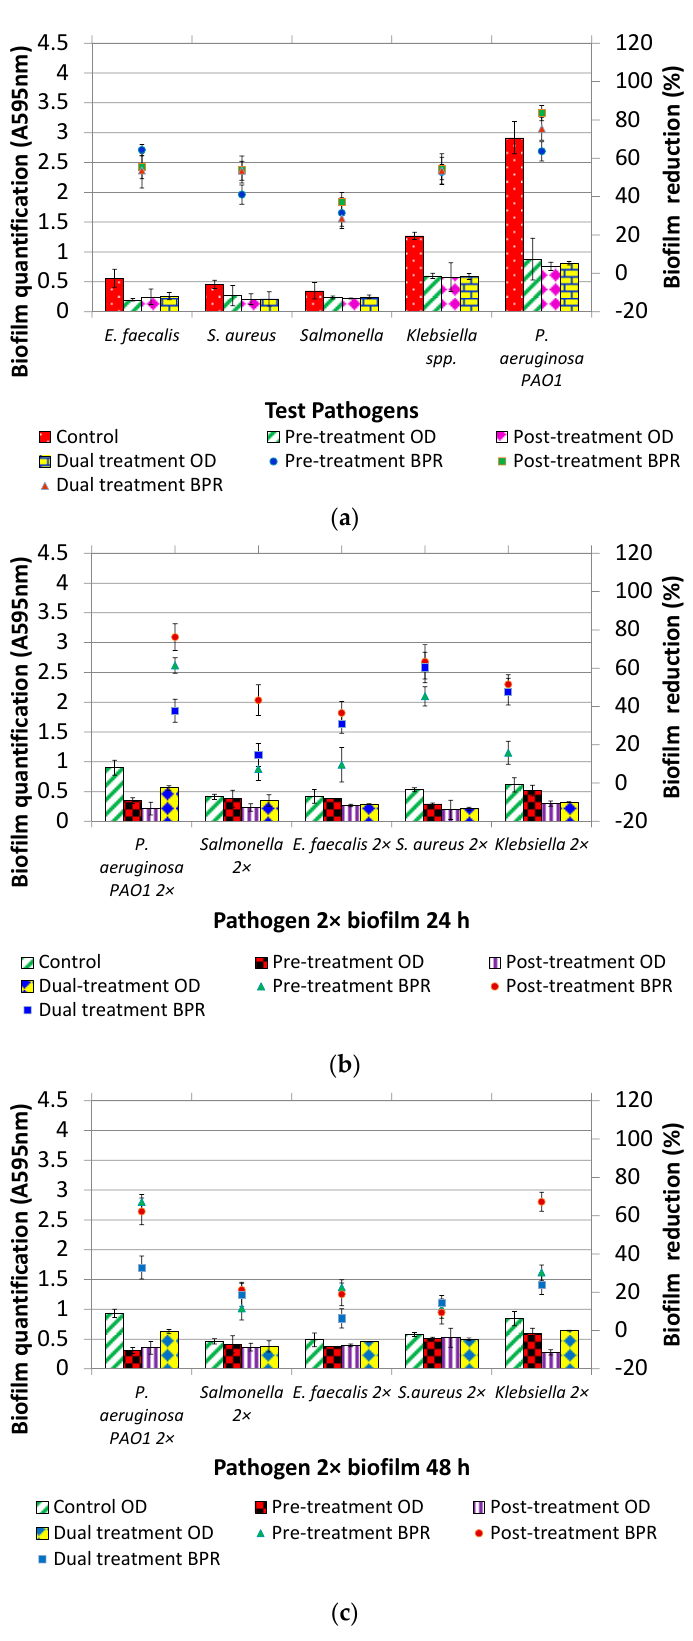
Figure 3. Effect of DNase I (without Mg 2+ ) pre-treatment, post-treatment and dual treatment on biofilms formed by ( a ) test organism (individual); ( b ) test organism 2× mixed species biofilm formed for 24 h; ( c ) test organism 2× mixed species for biofilm formed for 48 h.